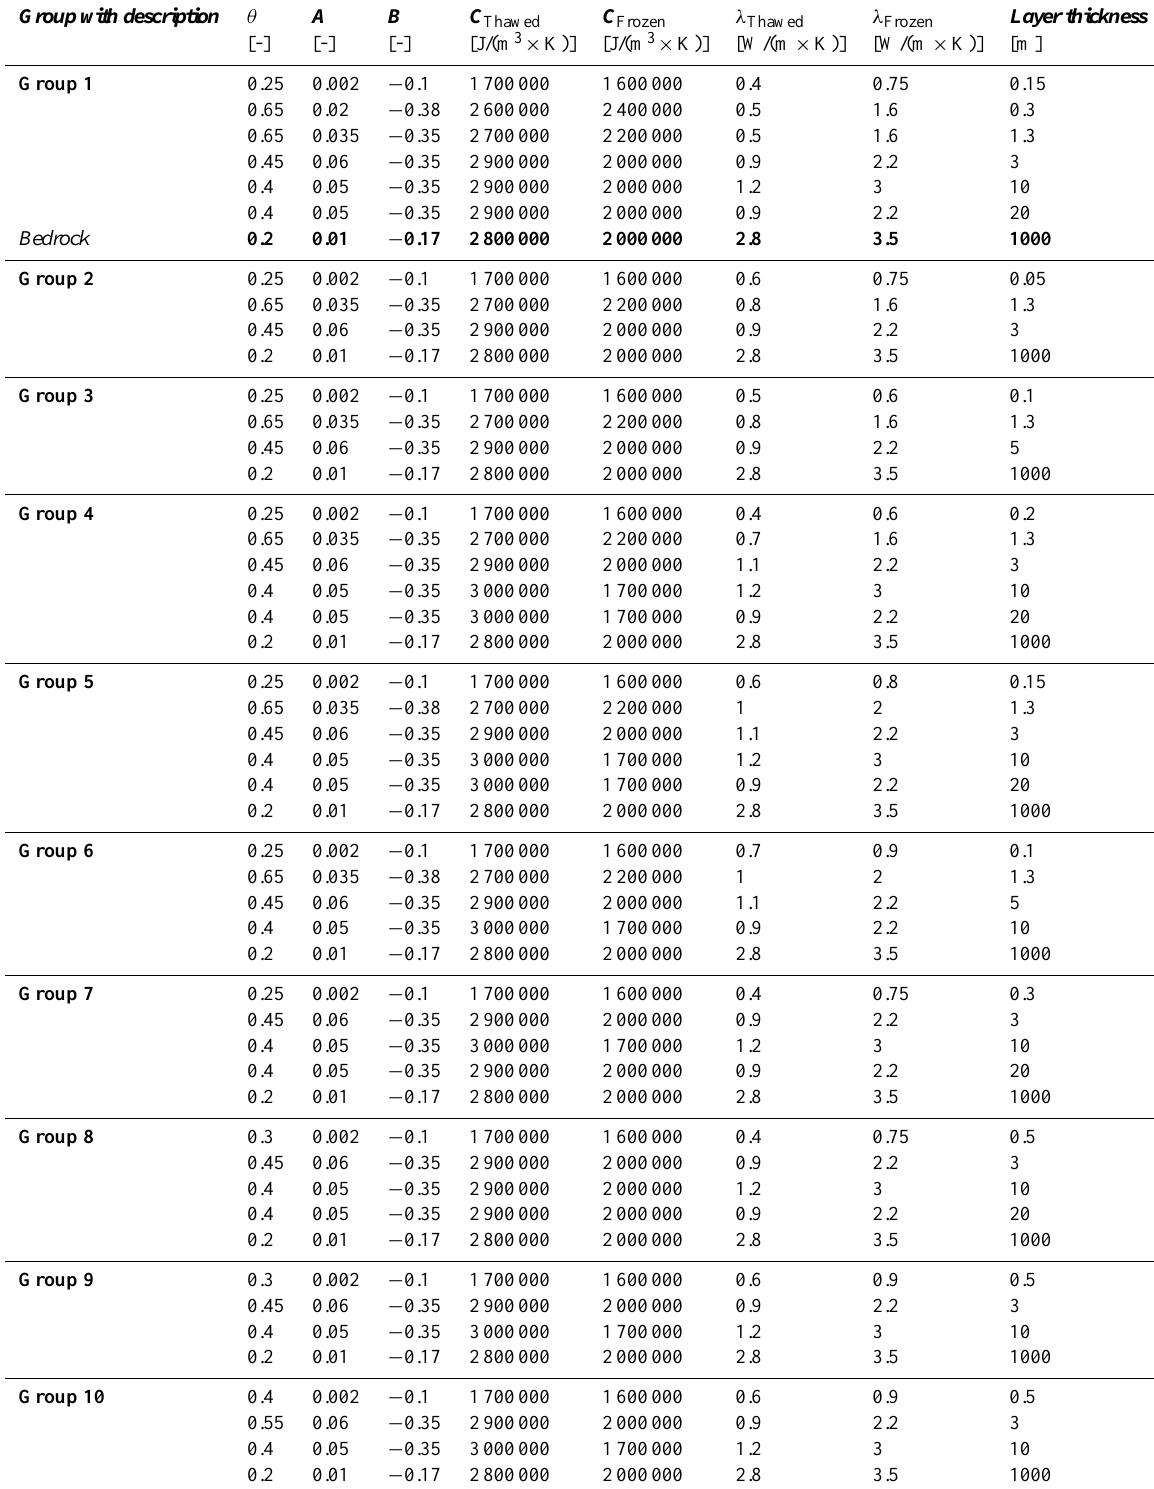
Table 2. Parameters in the sediments classification. For the bedrock simulation, all models are assigned the parameters of the deepest layer of Group 1 (highlighted in the table) except for the volumetric water content which is set to 0.1 in the bedrock simulations. In the column captions θ is the total volumetric water content, A and B are the parameters of the unfrozen water relationship Lovell (1957), C is the heat capacities and λ the thermal